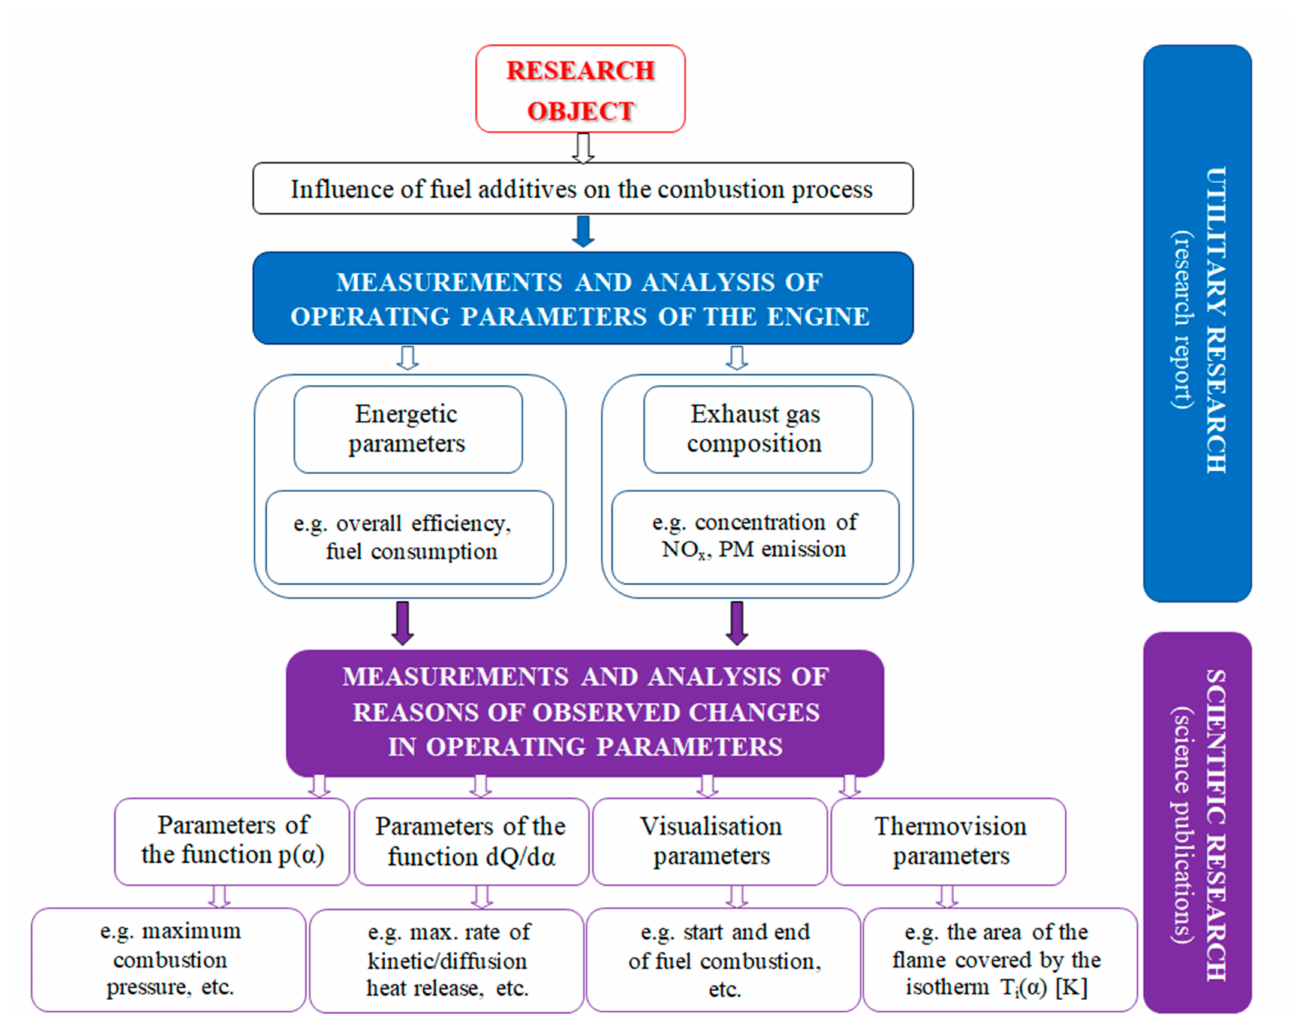
Figure 2. Analysis of “utilitary” and “scientific” parameters in relation to the conducted